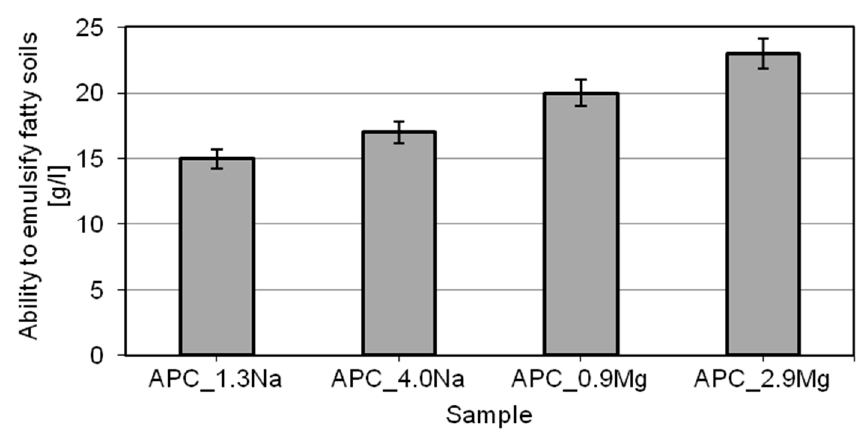
Figure 5. Ability of APCs to emulsify oily dirt.